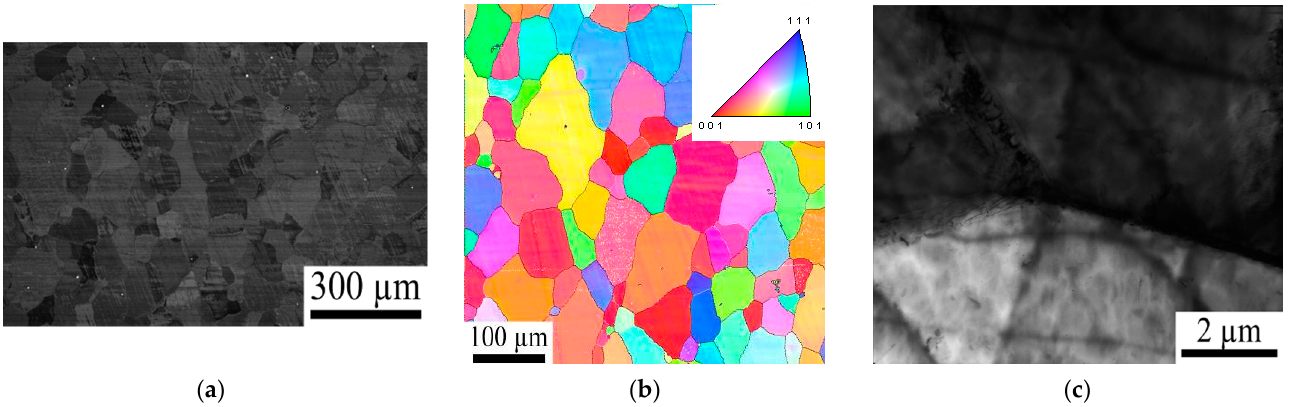
Figure 5. Microstructure of ARMCO iron in the initial state: ( a ) SEM image, ( b ) EBSD IPF map and ( c ) TEM image; the bottom edge of the SEM image corresponds to the surface of the specimen.